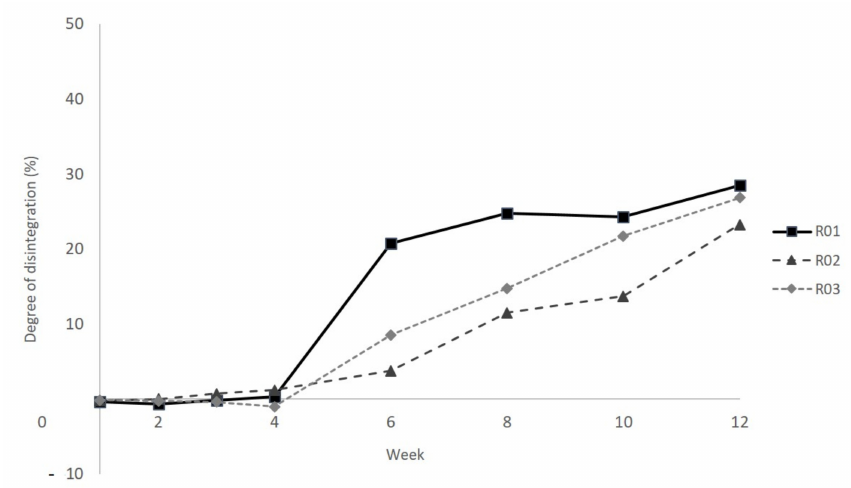
Figure 1. Influence of major and minor components of unfilled poly(lactic acid) (PLA)/poly(butylene succinate) (PBS), PBS/PLA and PLA/poly(butylene adipate-co-terephthalate) (PBAT) blend systems (ratio 7:3) on disintegration after defined times (measured on 2 mm thick plates). Compositions: R01: PLA/PBS (7:3); R02: PLA/PBS (3:7); R03: PLA/PBAT